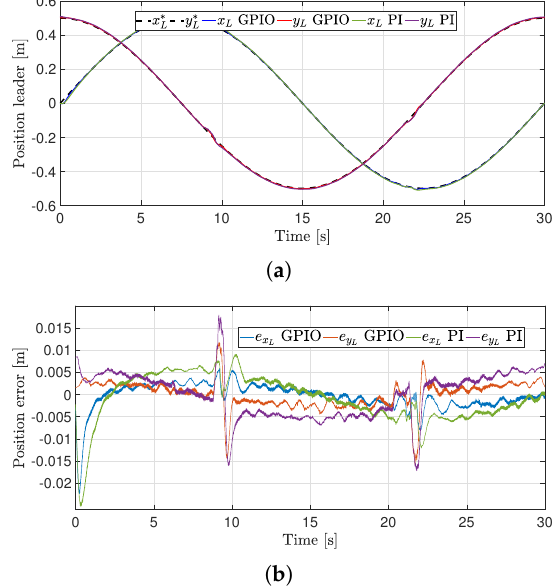
Figure 12. Leader trajectory tracking performance for the second experiment. ( a ) Leader tracking. ( b ) Leader trajectory error.